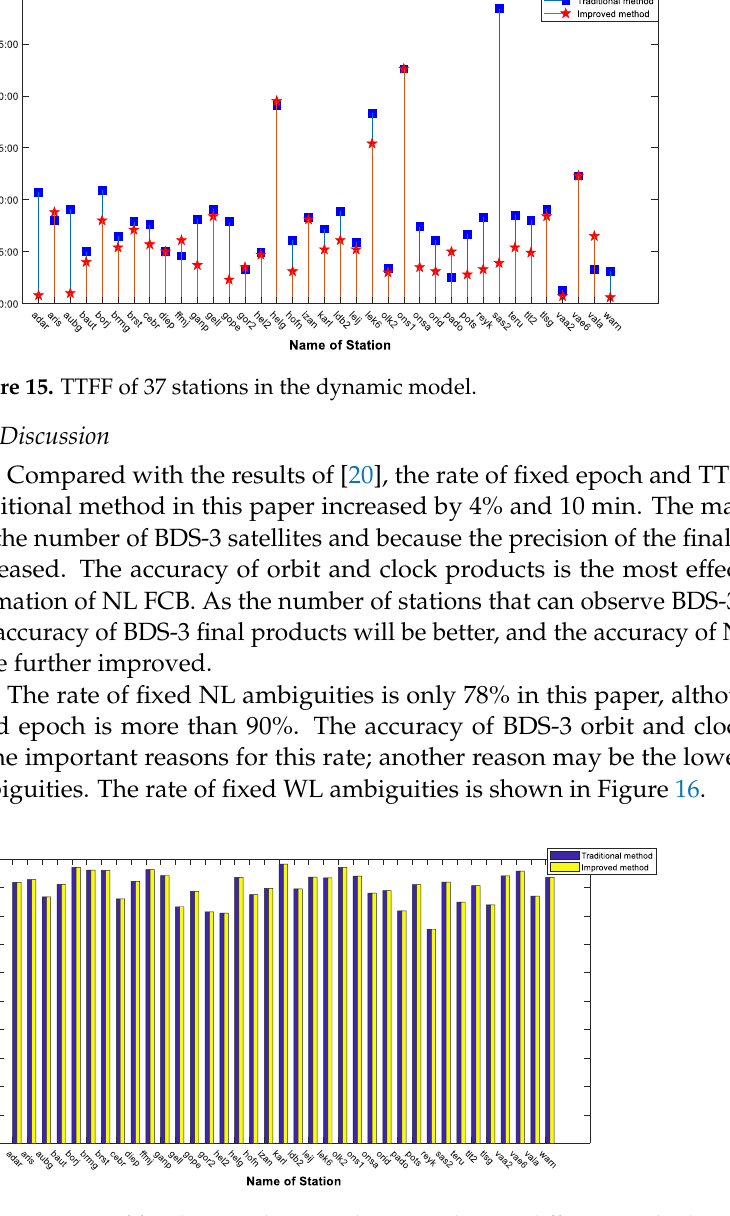
Figure 16. Rate of fixed WL ambiguities by using the two different methods.